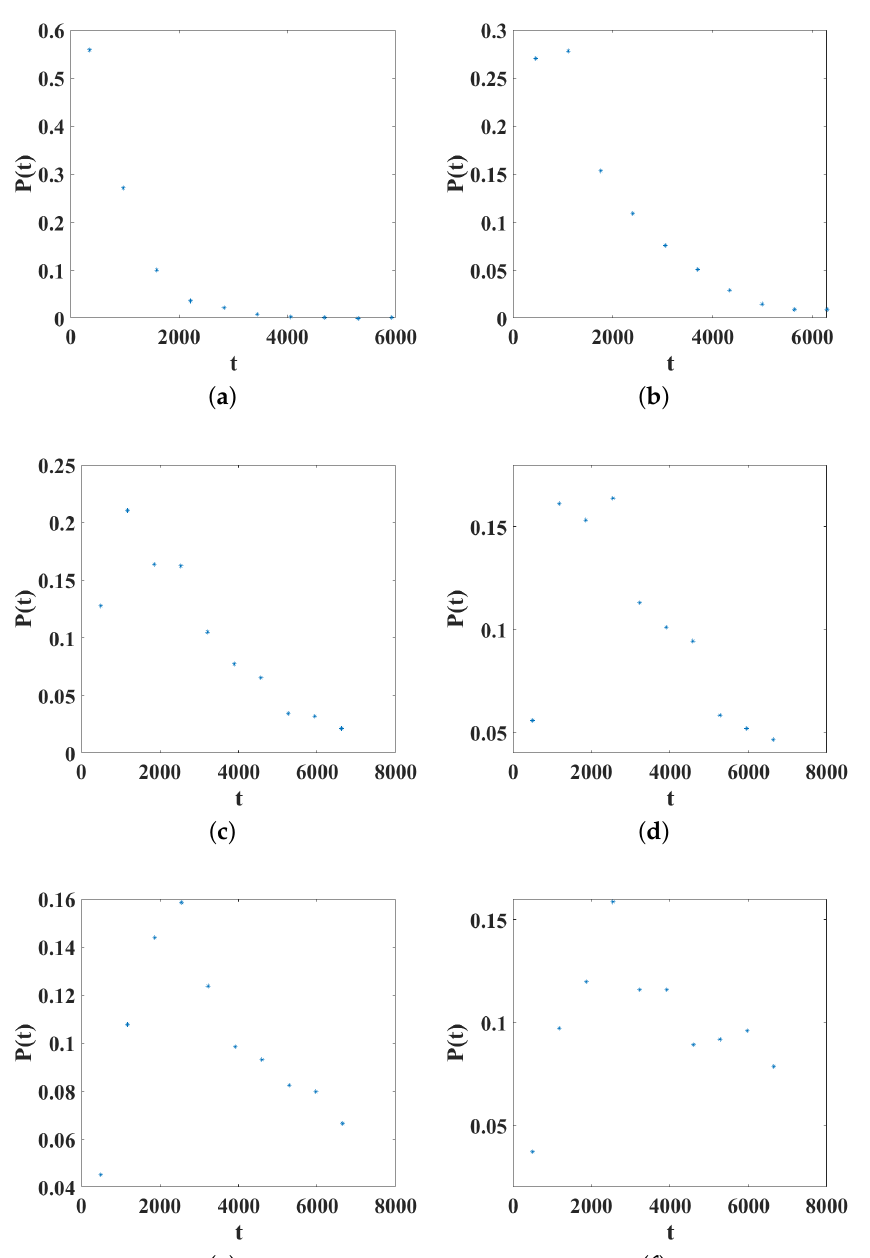
Figure 9. Time probability distributions considering different initial conditions r 0 = [ 0.1, v ] (cid:48) , v ∈ [ 0.1,1.5 ] for different values of m . ( a ) m = 4; ( b ) m = 6; ( c ) m = 8; 0 x ,0.1,0.4,0.1,0.1 0 x ( d ) m = 10; ( e ) m = 12; ( f ) m =